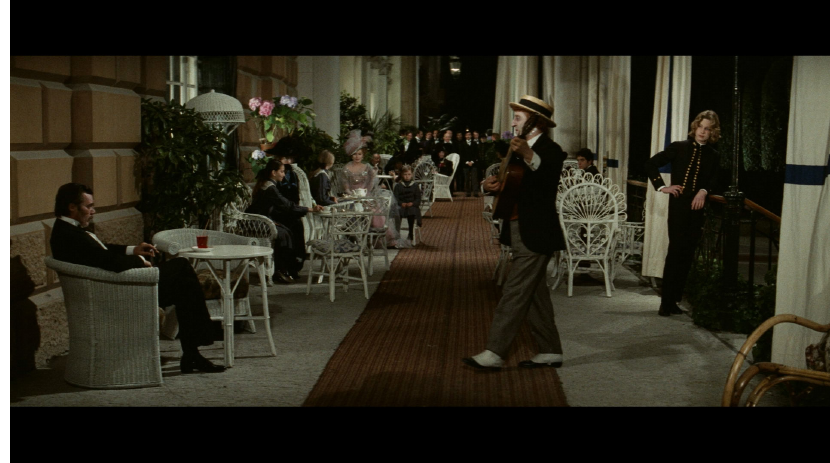
Fig. 1 Visconti, Death in Venice , the guitarist visits the